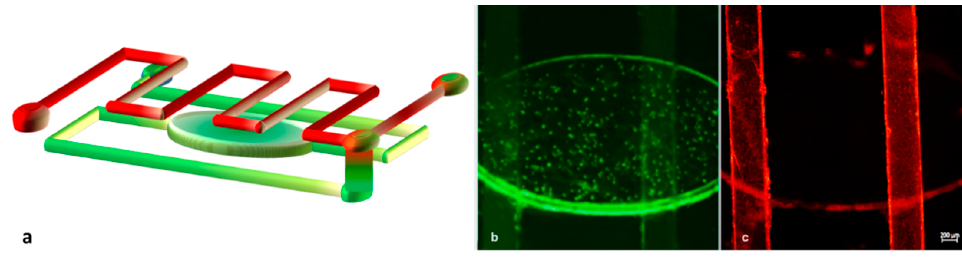
Figure 6. Solutions contained in the two channels flow separately into the device until they reach the interconnection point. ( a ) Scheme of the microchannel network filled with green and red nanoparticles. Green particles run in the bottom channel ( b ), while red ones run in the upper serpentine channel ( c ).